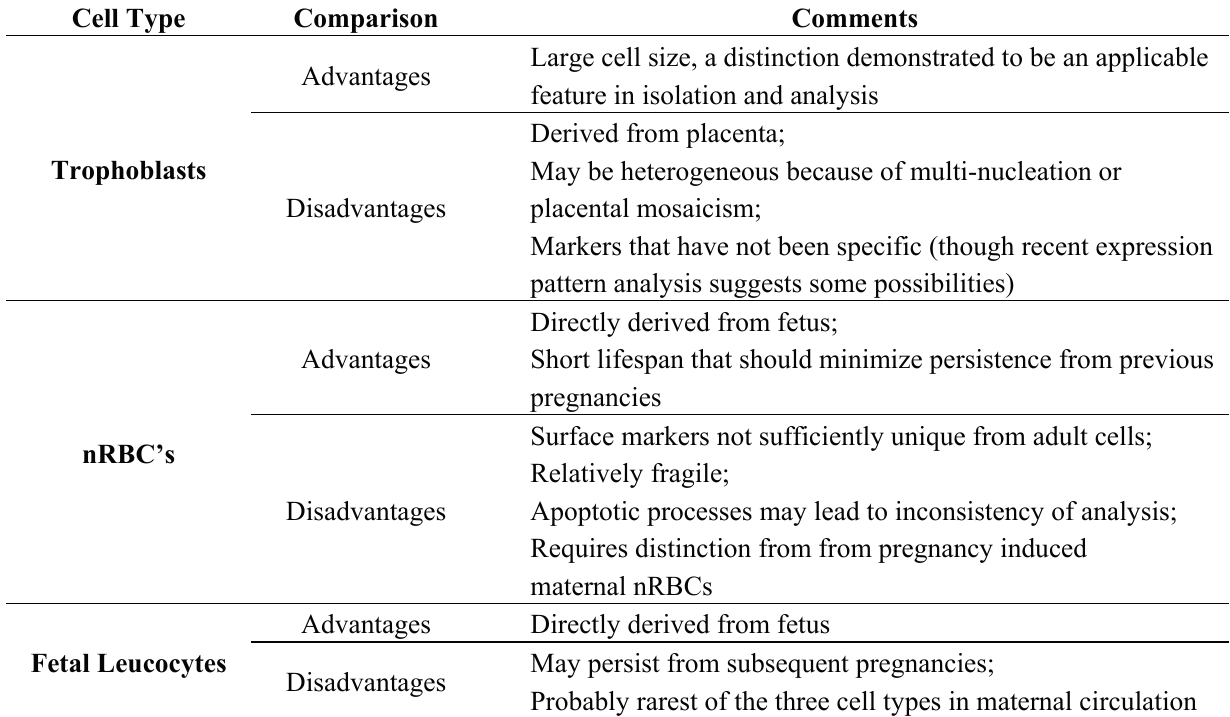
Table 1. Overview comparisons of trophoblasts, fetal nucleated red blood cells, and fetal leucocytes as sources for prenatal